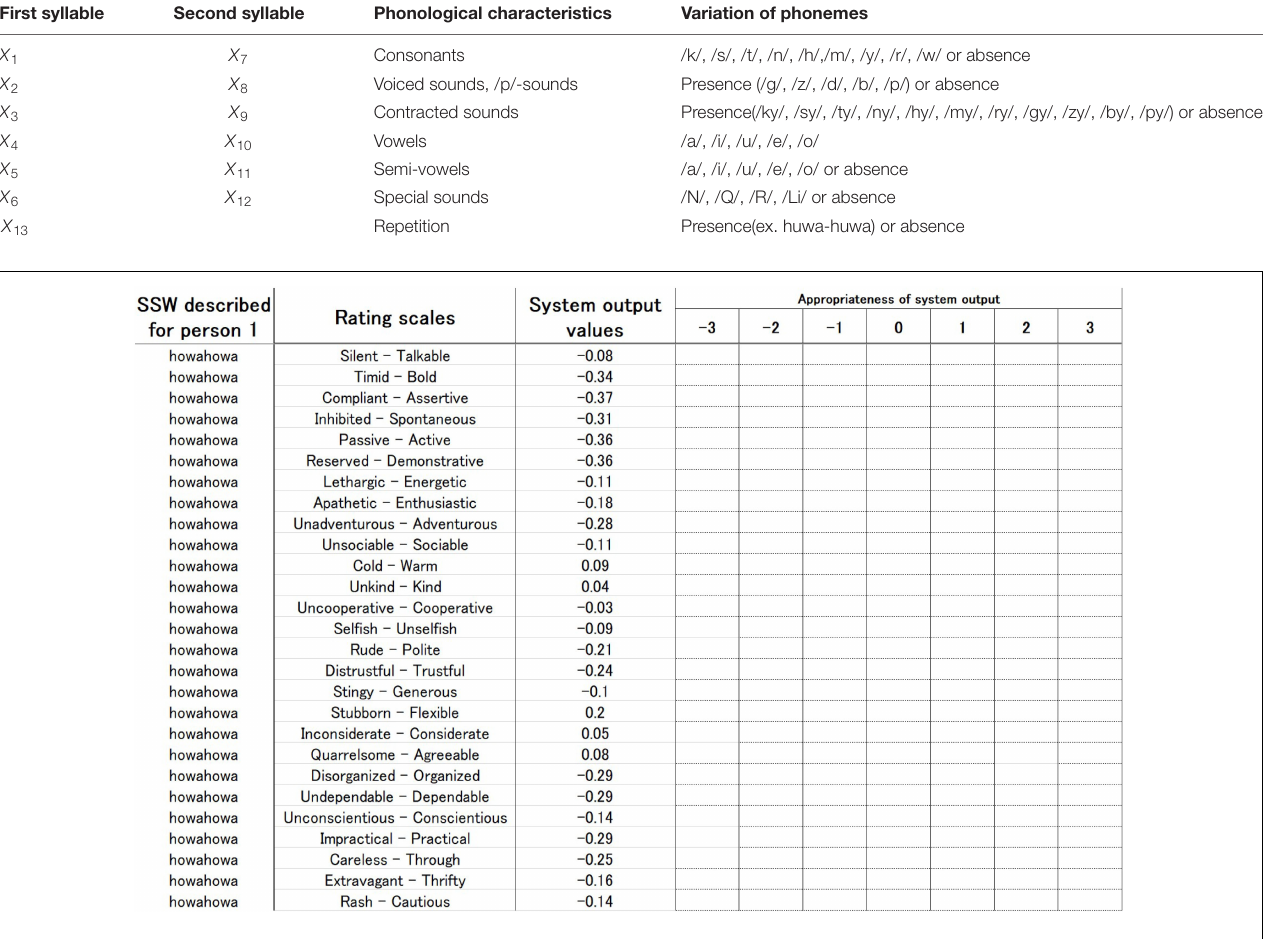
FIGURE 3 | Example of evaluation form (SSW described for person X; rating scales; system output value; and appropriateness of system